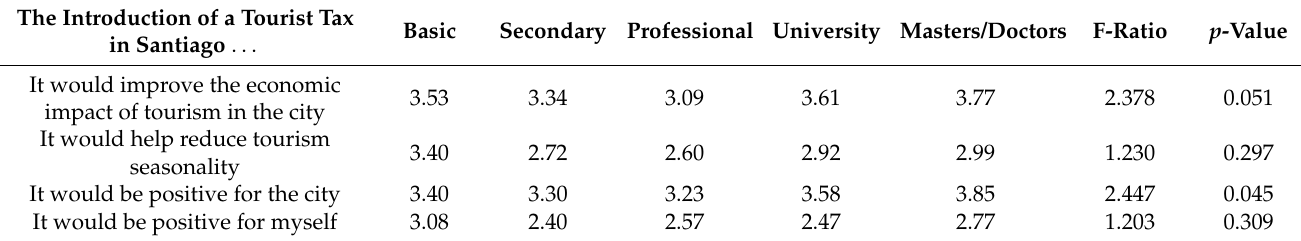
Table 4. Perception of the implementation of the tourist tax according to the level of education.